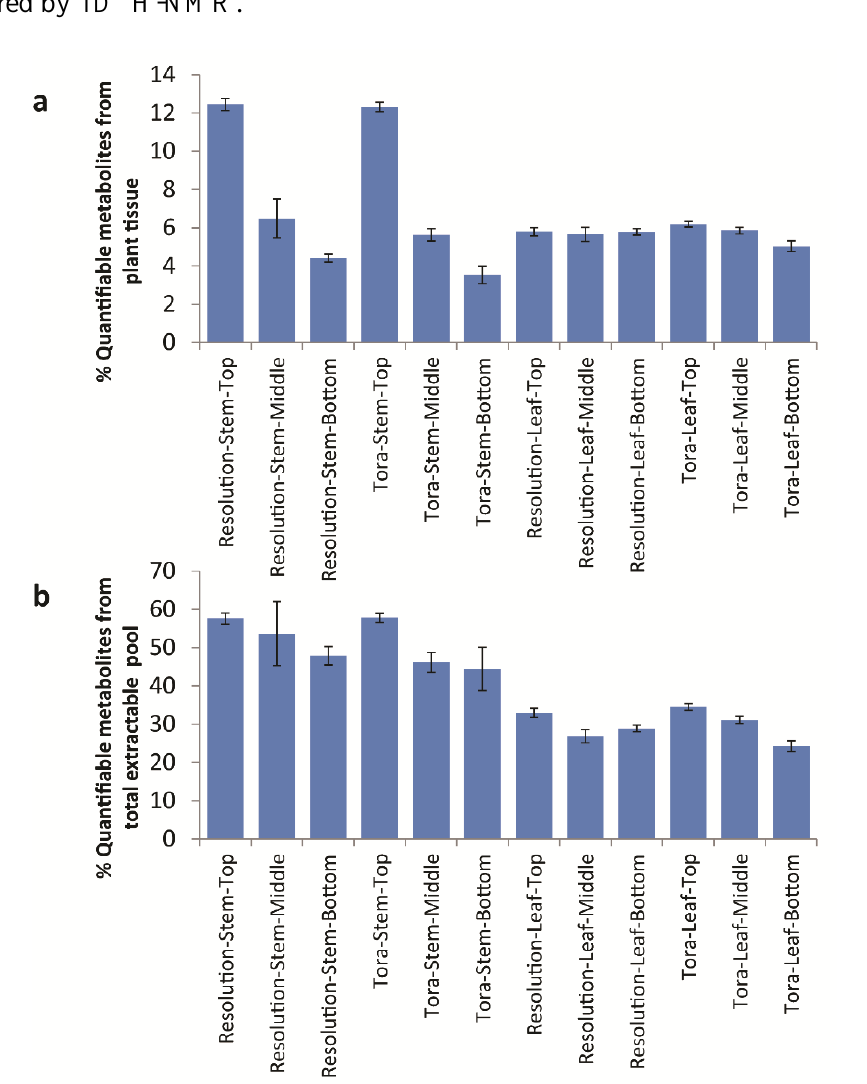
Figure 8. Calculated quantifiable metabolites (%) as a proportion of ( a ) total plant tissue and ( b ) total soluble metabolite pool. Data obtained from Chenomx quantification of metabolites as measured by 1D 1